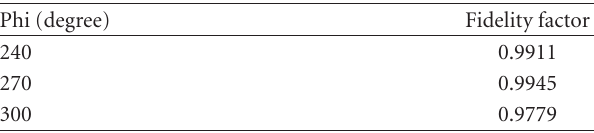
Table 1: Fidelity factors of the antenna with di ff erent angles of phi at theta = 90